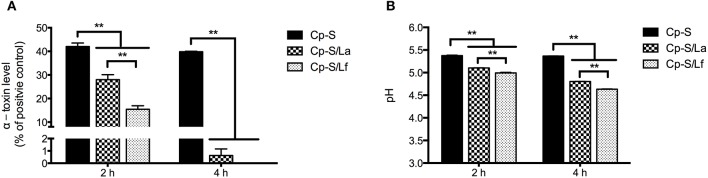
The degradation of C. perfringens α-toxin by lactobacilli and associated changes of culture pH. Either L. acidophilus or L. fermentum were added into the supernatants from C. perfringens cultures and incubated for 2 or 4 h. The α-toxin levels were detected by ELISA assay (A) and pH values were measured (B). Data are presented as mean ± standard error (n = 3). **P < 0.01. La, L. acidophilus; Lf, L. fermentum; Cp-S, supernatants from C. perfringens cultures.